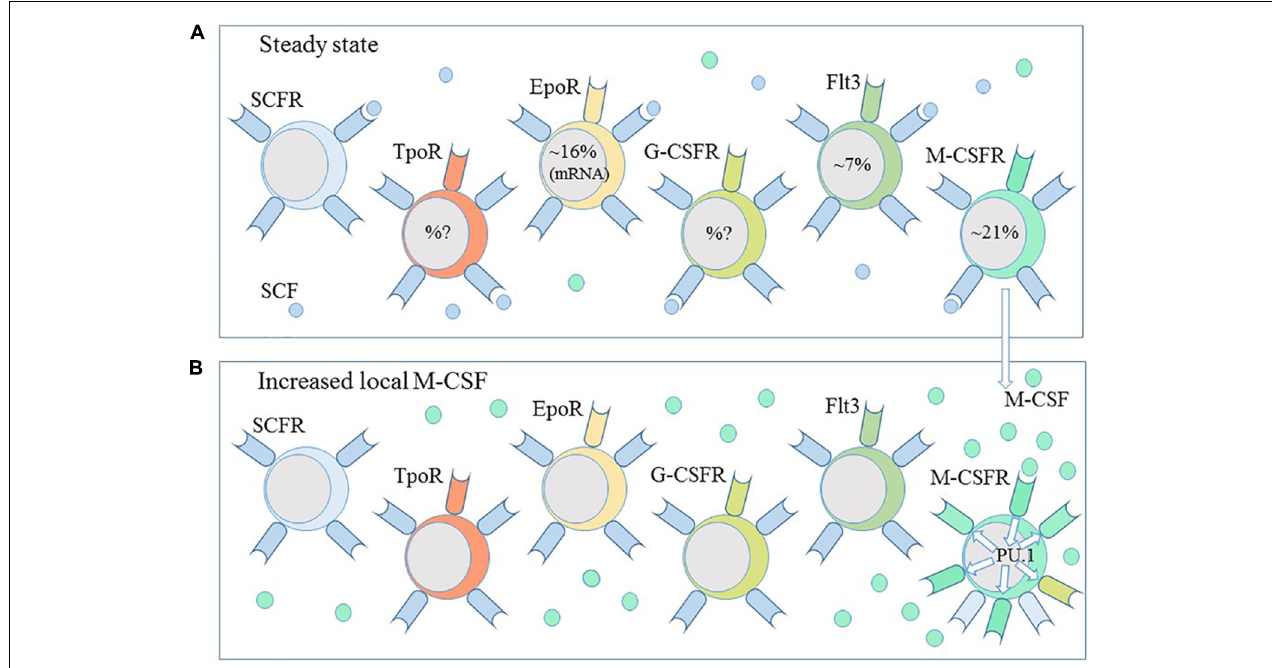
FIGURE 5 | Haematopoietic stem and progenitors are a heterogeneous population of cells. (A) Subpopulations of haematopoietic stem and progenitor cells express the receptors for the cytokines thrombopoietin (TpoR), erythropoietin (EpoR), granulocyte-colony stimulating factor (G-CSFR) and macrophage-colony stimulating factor (M-CSFR) and the fms-like tyrosine kinase receptor (Flt3). A combination of stem cell factor (SCF), thrombopoietin and the ligand for Flt3 is sufficient to ensure the survival of HSCs ex vivo . (B) M-CSF instructs myeloid lineage fate in HSCs and the expression of PU.1. PU.1 regulates the expression of M-CSFR and G-CSFR. A local increase in M-CSF and autoregulation of M-CSFR expression might guide HSC toward a macrophage progenitor